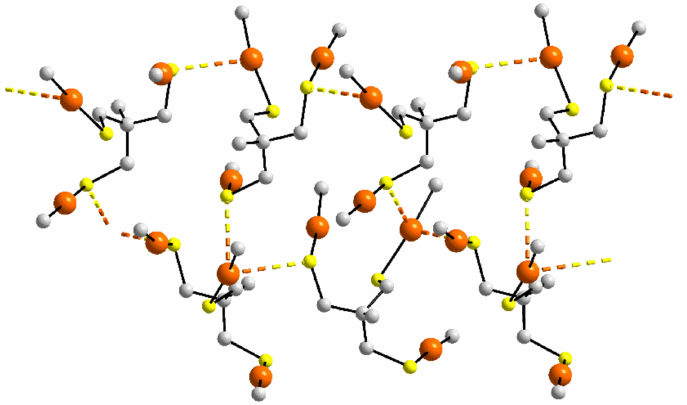
Figure 14. Supramolecular association in a one-dimensional aggregate featuring three Hg ··· S interac- tions per trinuclear molecule: 41